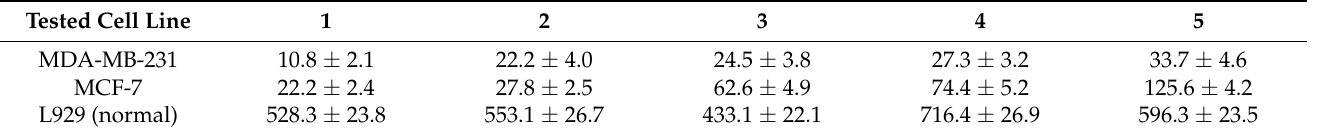
Table 3. Cytotoxic activity [IC 50 ( µ M)] of compounds 1–5